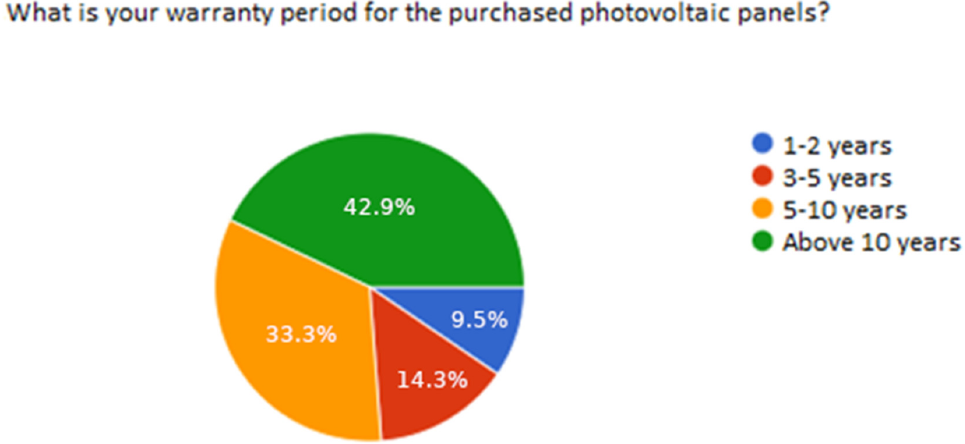
Figure 20. Guarantee period.